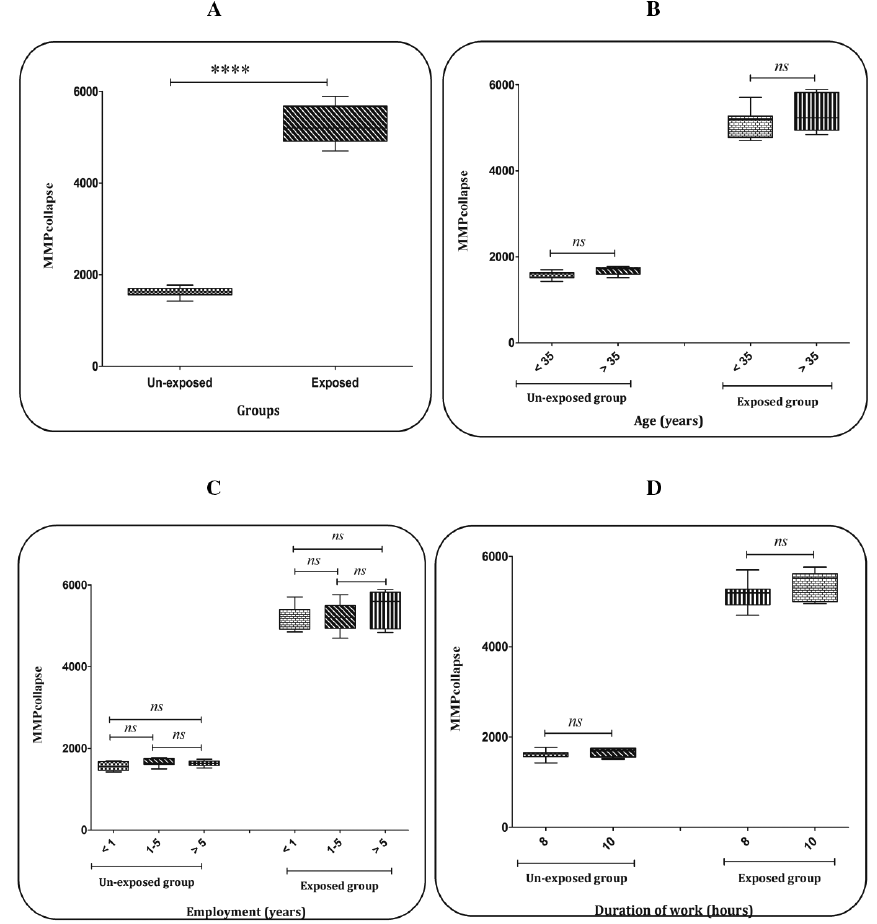
Figure 3: MMP assay. (a) Comparison between exposure and non-exposure groups. (b) Comparison between the exposed and unexposed groups based on age (year). (c) Comparison between the exposed and unexposed groups based on employment (year). (d) Comparison between the exposed and unexposed groups based on duration of work (hours). Data are presented as mean ± SD (n = 20). **** P < 0.0001. The unit of measurement of MMP collapse is based on fluorescent